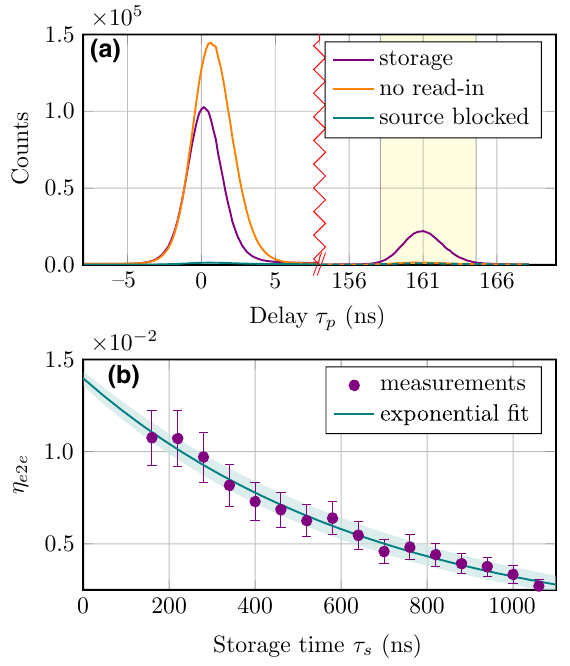
FIG. 3. (a) Photon arrival-time histograms for storage experi- ments showing the initial leakage of photons through the memory and the retrieval after 160 ns of storage. The data are his- togrammed in 162 ps bins. As no intermediate features are visible on a linear scale, the time axis is broken to show only these peaks. The shaded area marks the 6.48-ns- (80 × 81 ps) wide region of interest for the retrieval for which all figures of merit in the text are specified. Almost no noise counts are visible on a linear scale. (b) Memory lifetime as measured by a drop in efficiency and modeled exponentially as η e 2 e (τ s ) = η e 2 e ,0 exp ( − τ s /τ) . The shaded region marks the 1 σ confidence interval of the fit. Each point represents a storage and retrieval experiment as depicted in (a), where each curve is integrated for 5 min. These data were collected a day after the main results without optimizing the fil- ters anew, and have thus been scaled to account for a slightly lower setup transmission of about